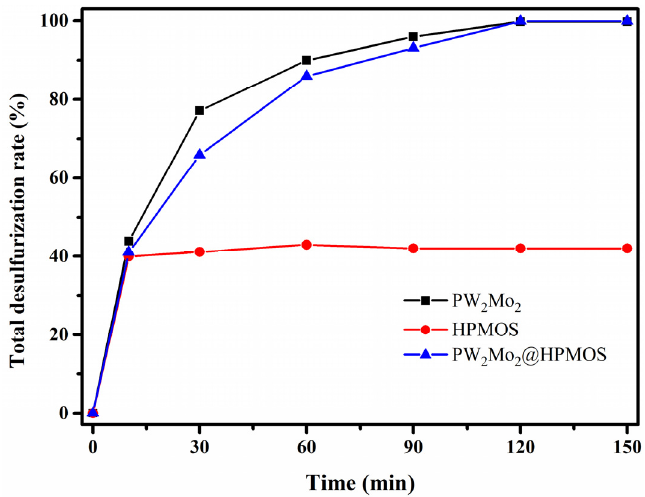
Figure 6. Desulfurization profile of a multicomponent model fuel using 5 µ mol PW 2 Mo 2 , 32.5 g HPMOS or PW 2 Mo 2 @HPMOS, containing 5 µmol PW 2 Mo 2 , [Bmim]PF 6 extraction solvent, and H 2 O 2 oxidant at 70 °C.